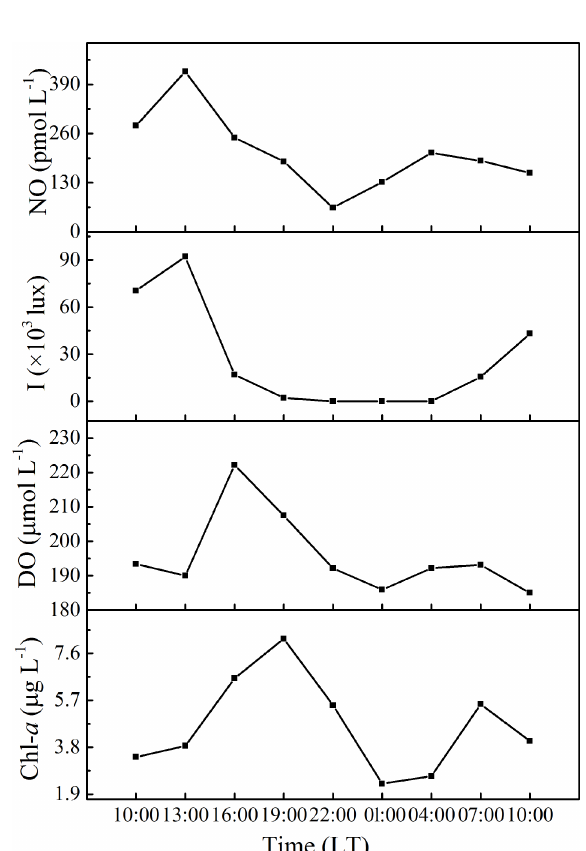
Figure 4. Diurnal variations in NO concentrations, illuminance ( I ), DO, and Chl a concentrations in the surface water at anchor sta- tion